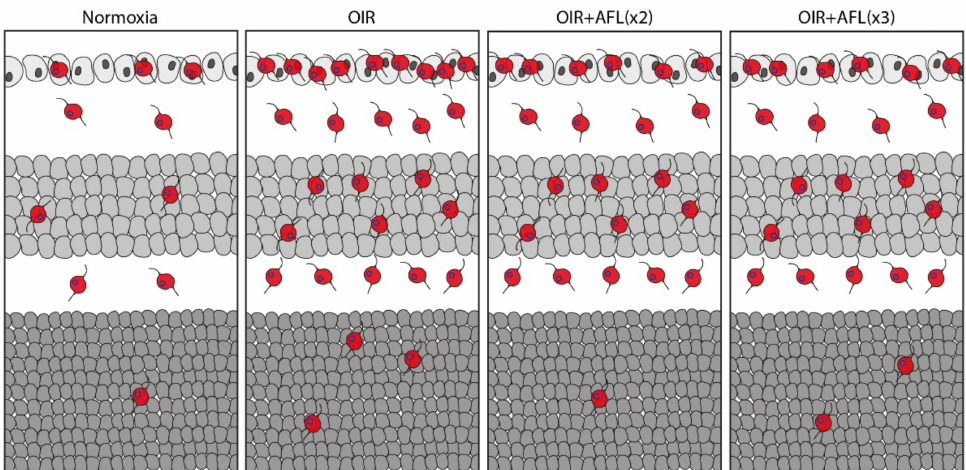
Figure 4. Schematic representation of Iba1+ cells in P19 cross-sections of normoxic, OIR, OIR+AFLx2, and OIR+AFLx3 retinas. Retinal tissue layers are shown in the following order: ganglion cell